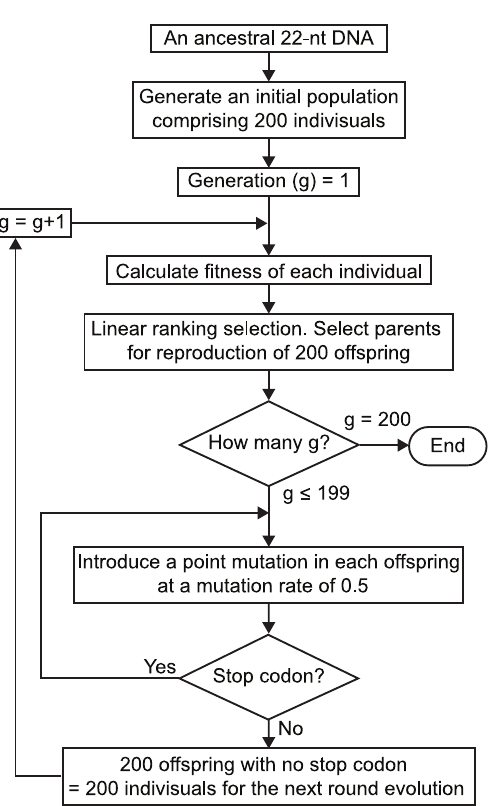
Figure 6. A flowchart of the evolutionary algorithm. This flowchart outlines the steps involved in the computational directed evolution of 22 nucleotide-long DNA coding the VP/AAV-overlapping heptapeptides.